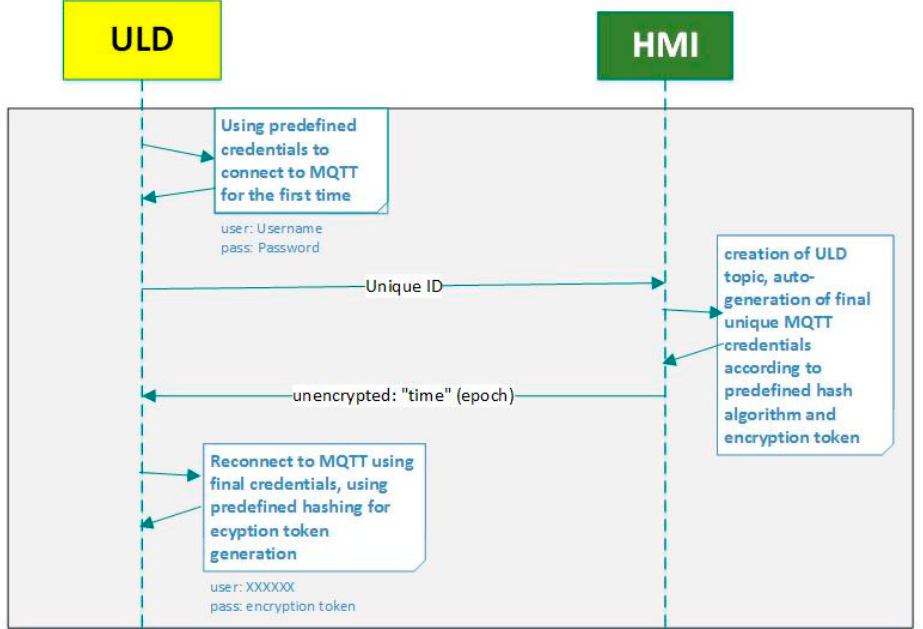
Figure 8. MQTT Ack - encryption key exchange.